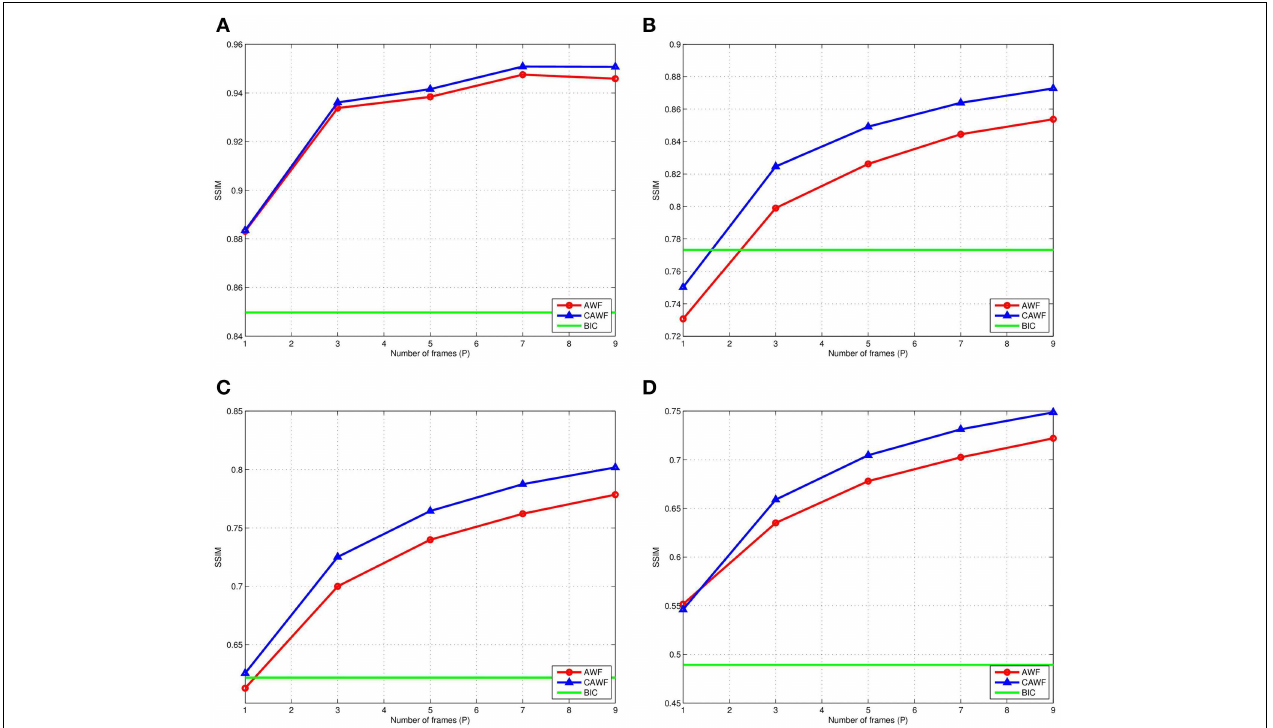
1 , (B) σ η 5 , (C) σ η 10 , and (D) σ η 15 . These = = = =